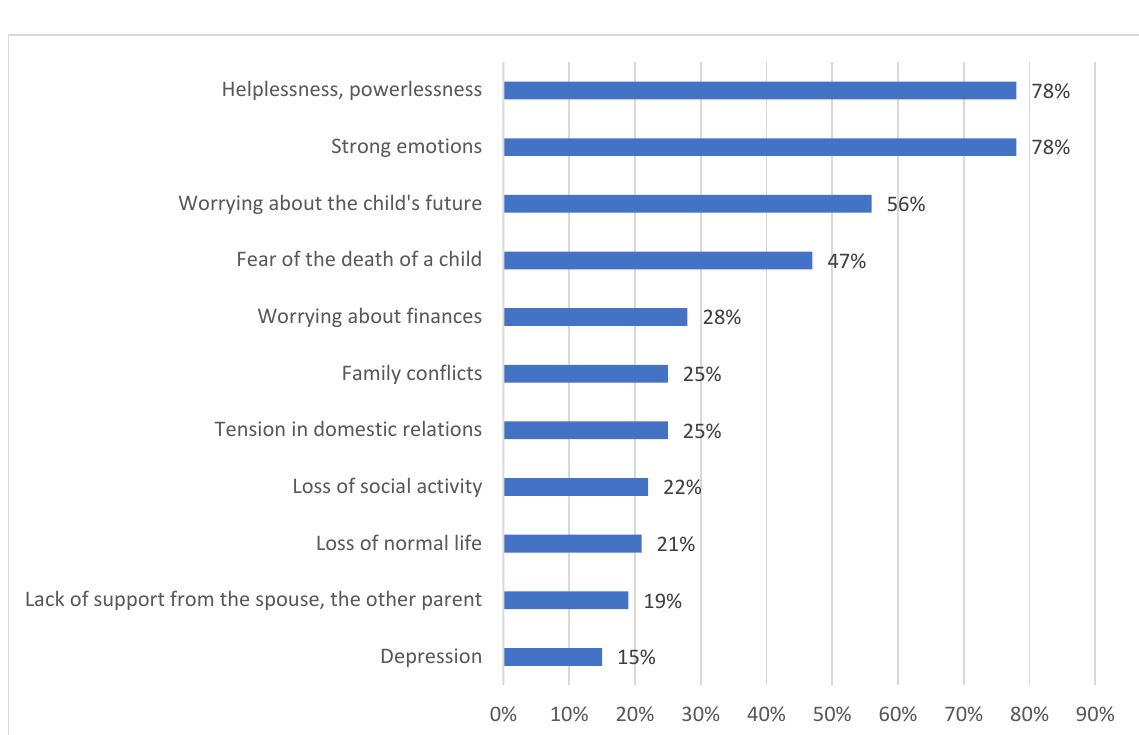
Figure 3. Reasons for using a psychologist.